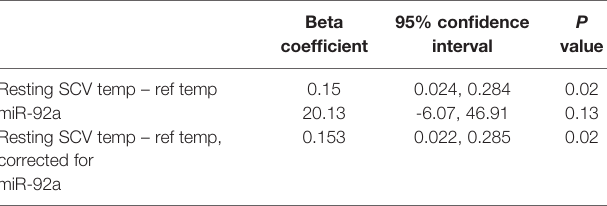
TABLE 2 | Effects of LT3 vs . LT4 mediation analysis of miR-92a on resting supraclavicular (SCV) temperature minus sternal reference